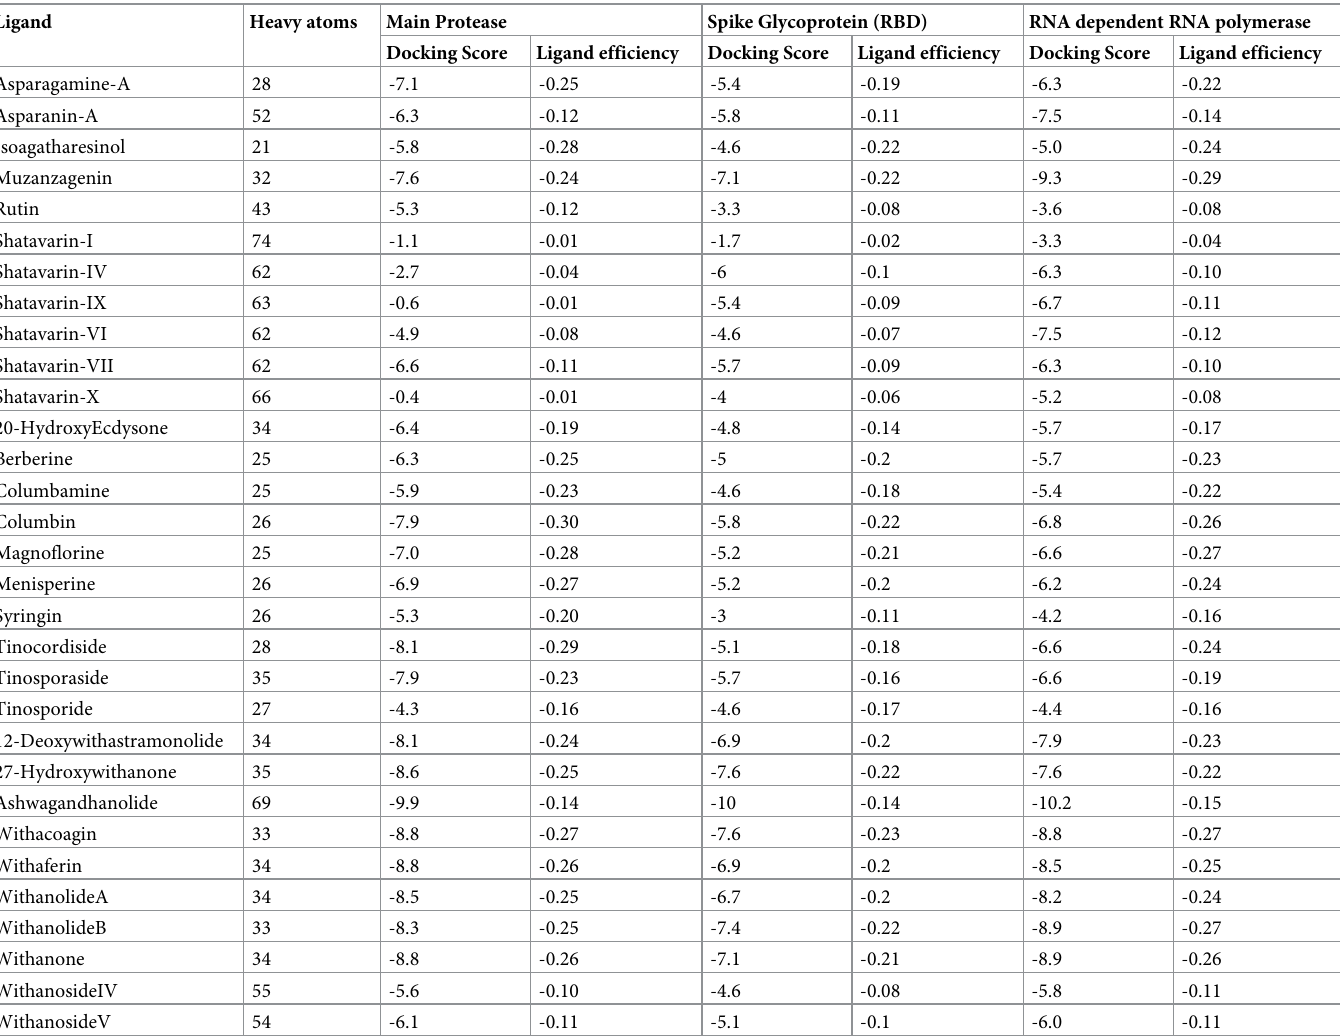
Table 2. Docking results of the phytoconstituents from AR, TC and